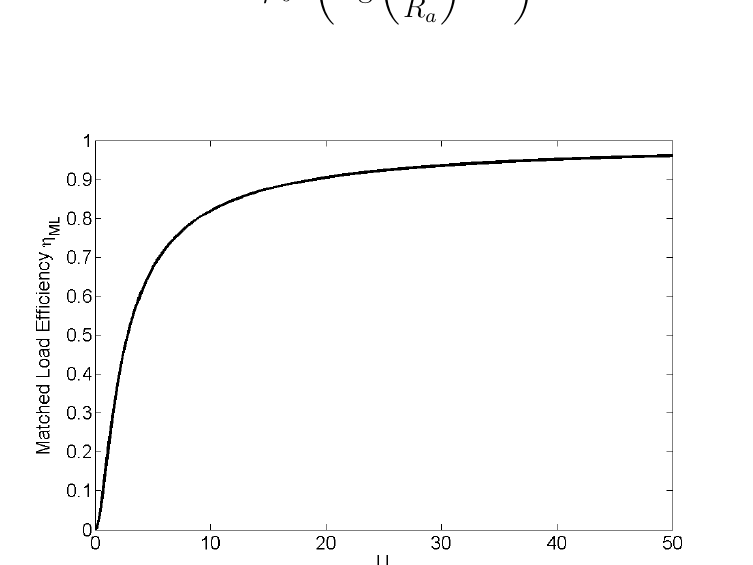
Figure 1. Variation of matched-load efficiency η